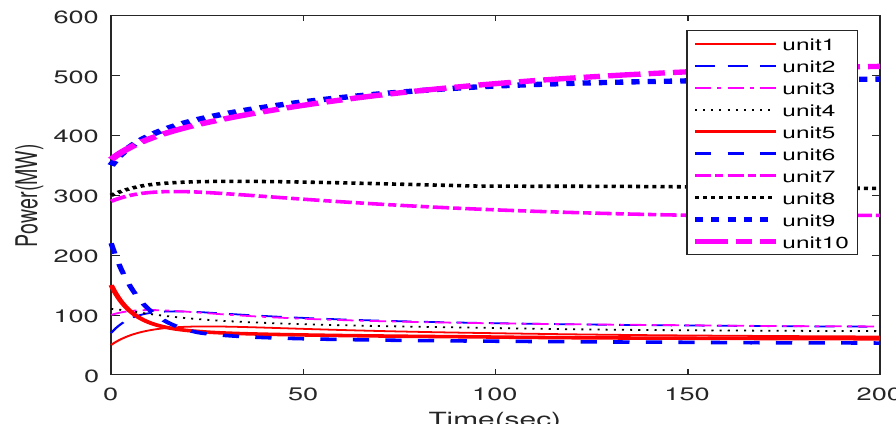
Figure 4. Output power of ten generation nodes without capacity constraint.